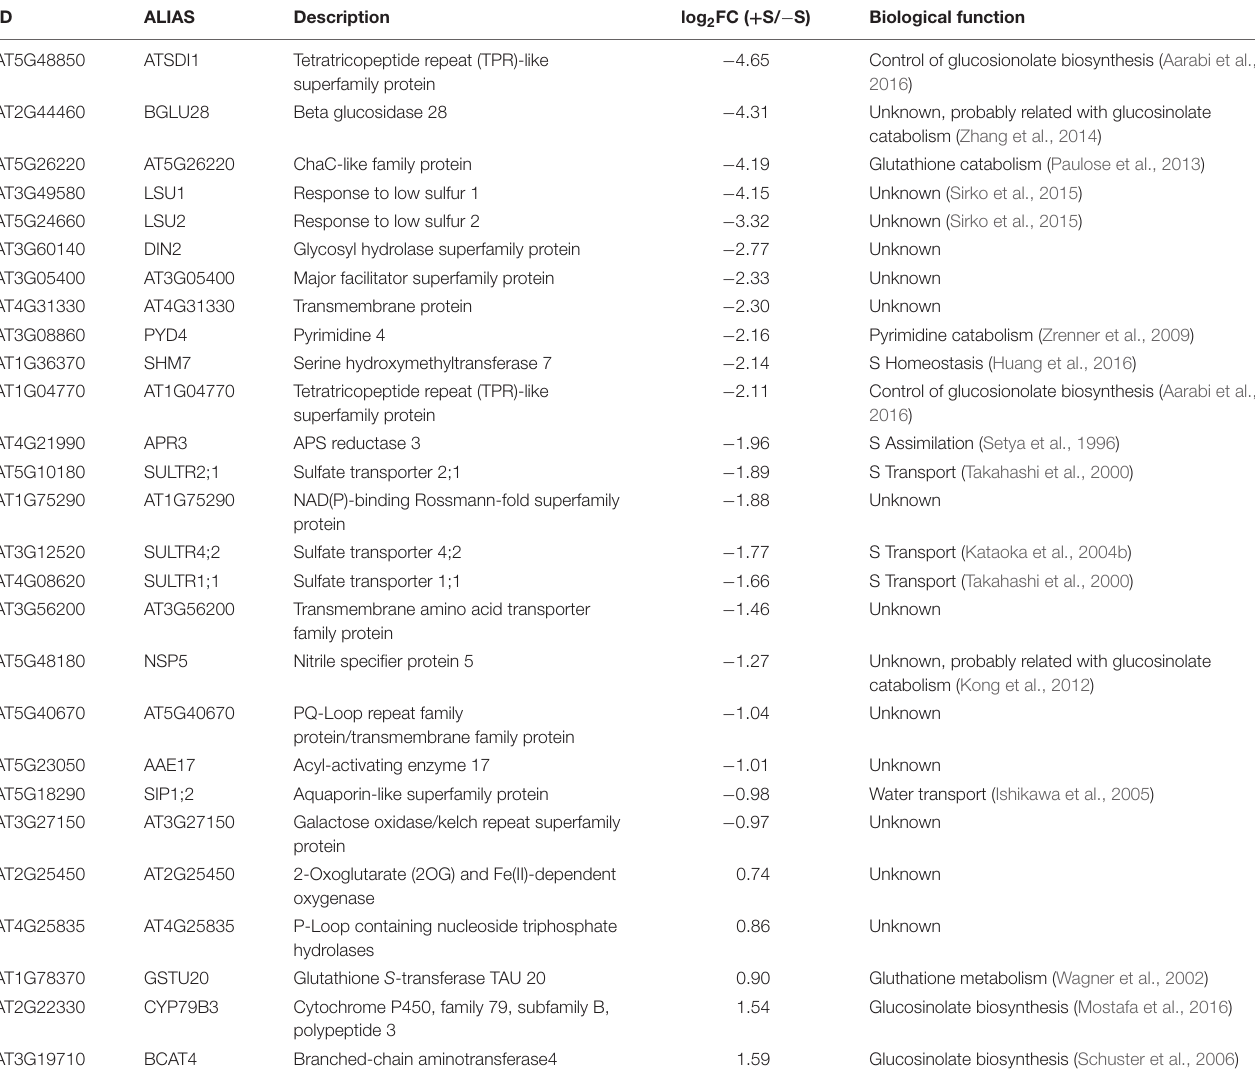
TABLE 2 | Set of genes that significantly responded to sulfate in all the experiments analyzed (FDR < 5% and log 2 |FC| >